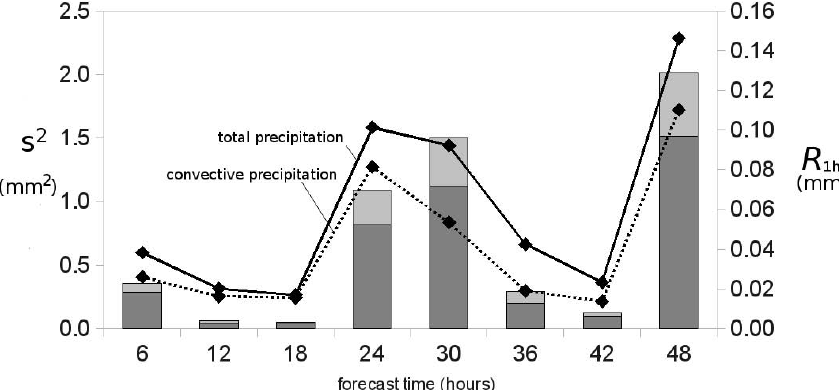
Fig. 5. Variance of 1-hourly precipitation accumulations among members driven by the same initial and boundary conditions ( s 2 variance ; dark grey bars), and the variance among all simulations ( s 2 tot , total variance ; complete bars), and the spatially averaged 1-hourly accumulated convective (dotted line) and total (continuous line) precipitation at 8 different forecast times for case W1. The accumulations are over the hour preceding the respective forecast time.